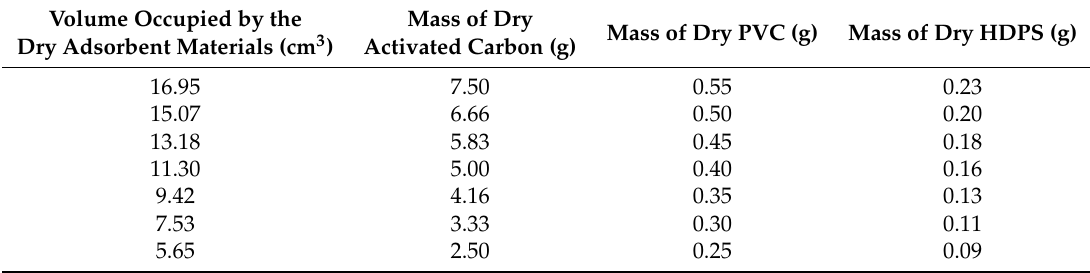
Table 1. Masses of adsorbents used for the adsorption isotherms experiments.